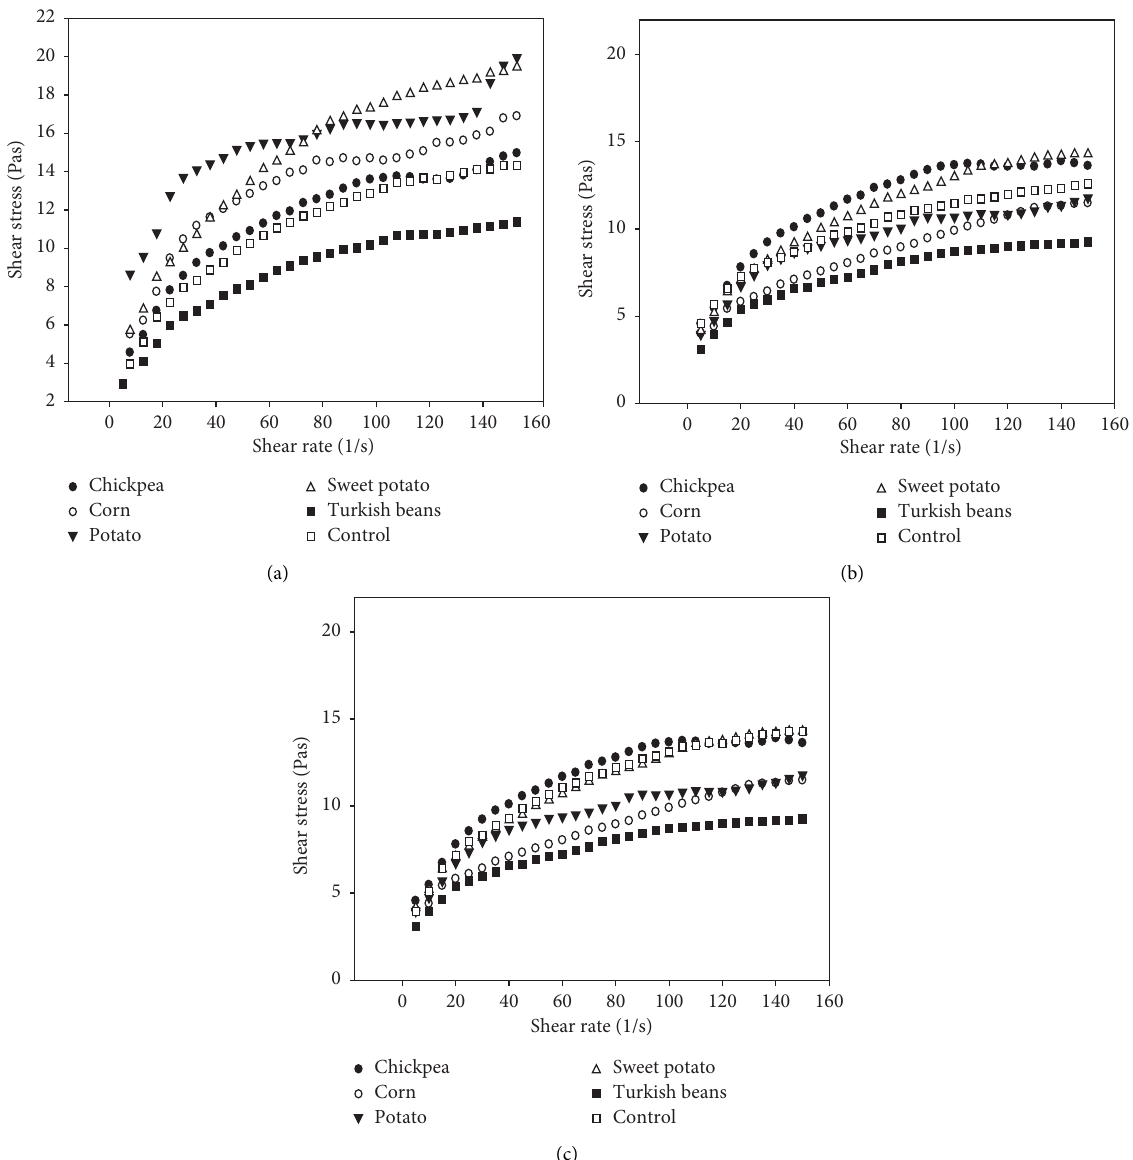
Figure 1: Shear rate/shear stress relationship for yogurt fortified with okra gum and different starches: (a) at the beginning of the cold storage, (b) after 7 days, and (c) after 15